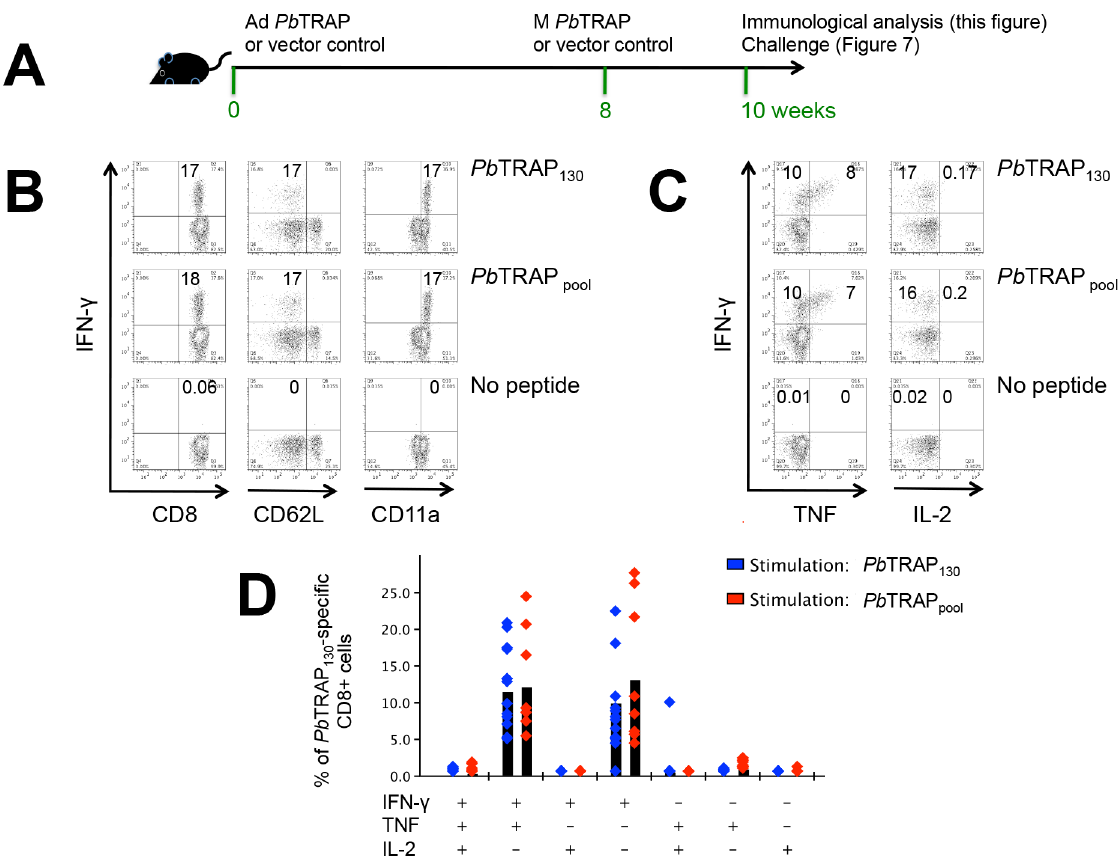
Figure 6. Vaccination with Pb TRAP elicits high levels of Pb TRAP 130 -specific CD8 + T cell responses. ( A ) Schematic diagram of methodology. B6 mice were immunised with Ad Pb TRAP (or Ad vector control) and boosted eight weeks later with M Pb TRAP (or M vector control). Two weeks later, the frequencies and quality of Pb TRAP-specific CD8 + T cells on peripheral blood leukocytes were quantified by ICS. ( B ) Flow cytometry plots of IFN- c co-staining with markers of effector and effector memory phenotypes (CD62L lo and CD11a hi ). Cells were either not stimulated (no peptide) or stimulated with Pb TRAP 130 (5 m g/ml) or with a pool of 20-mer peptides overlapping by 10 amino acids spanning Pb TRAP ( Pb TRAP pool : final concentration is 5 m g/mL for each peptide). ( C ) Flow cytometry plots of IFN- c co-staining with other effector cytokines, TNF and IL- 2. Figures are representative data from one of 4 experiments with 5 mice/group/experiment. ( D ) Polyfunctional analysis of cytokine secretion based on (C). Bars represent the mean value of the % of Pb TRAP 130 -specific CD8 + cells. Individual data are also shown (blue diamond for Pb TRAP 130 and red diamond for Pb S20 318 ). Figures B, C and D are representative data from one of at least 4 experiments with 4–5 mice/experiment.